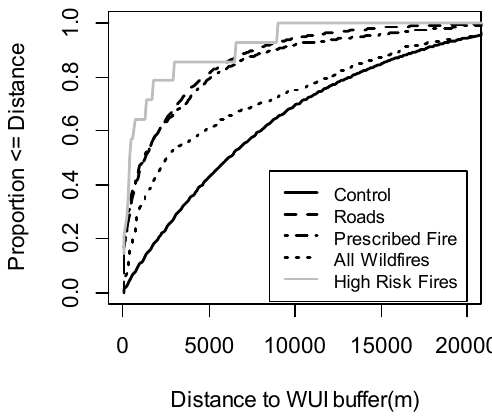
Fig. 5. The cumulative distribution of distance to the WUI buffer for a series of features: random landscape points; roads; prescribed fires; wildfires and wildfires that burnt the WUI buffer on days with FFDI = 0 (High Risk Fires). The y axis is the proportion of each feature type that is 5 to the defined distance on the x